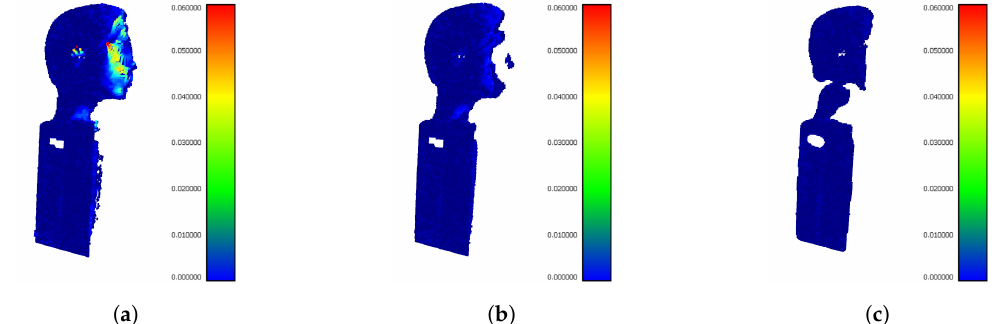
Figure 10. The difference in evaluation using Hausdorff distance and F1 Score. ( a ) Point cloud with interference points. The mean Hausdorf distance is large. ( b ) Precisely filtered point cloud. The mean Hausdorff distance is low and F1 score is large. ( c ) In this case, large number of useful points were lost. The mean Hausdorff distance is still low but also F1 score is